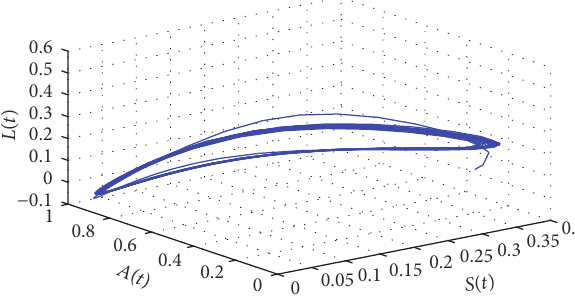
Figure 16: The phase plot of states 𝑆 ∗ , 𝐿 ∗ , and 𝐴 ∗ with 𝜏 1 = 22.4057 > 18.6255 = 𝜏 󸀠